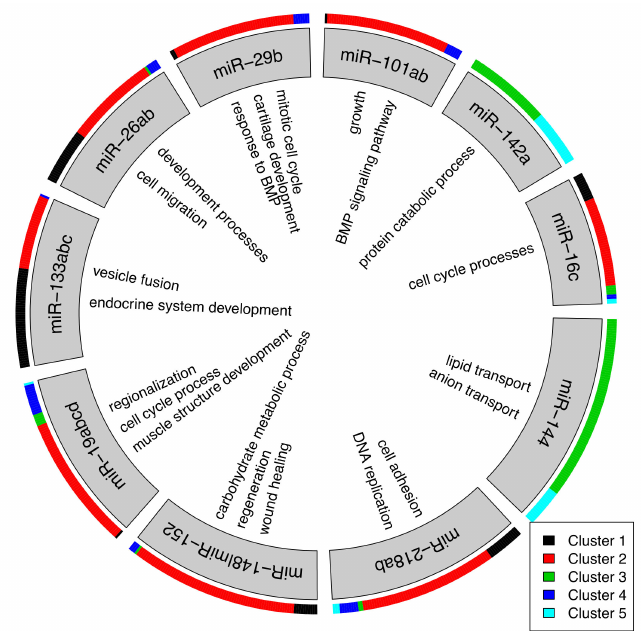
Figure 5. Top 10 miRNAs with the most predicted target genes from clusters 1–5 (Figure 4A). miRNAs were combined if they shared a significant overlap of target genes, e.g., miR-148 and miR-152 (hypergeometric Test p -value < 0.05). A selection of Gene Ontology (GO) terms are shown in inner circle that were enriched for the target genes. A full list of all mRNA-miRNA interactions can be found in Supplementary Table